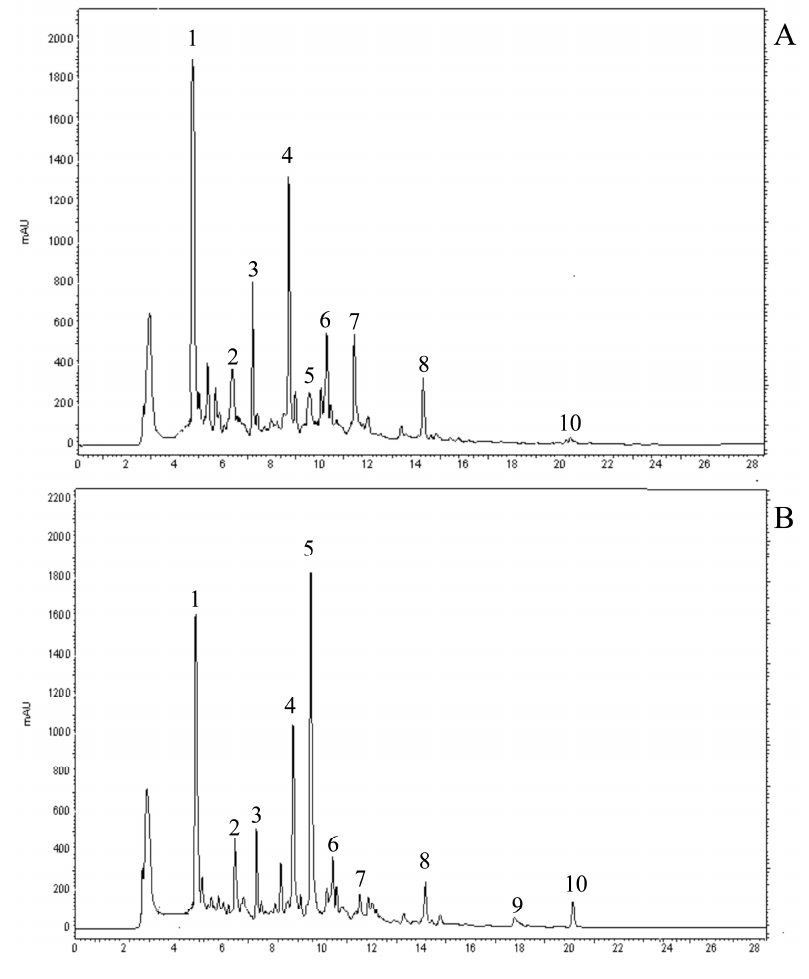
Figure 1. HPLC chromatograms of phenolic compounds in E92 before ( A ) and after ( B ) processing detected at 330 nm. Peaks: 1, chlorogenic acid; 2: caffeic acid; 3, 5- p -CQA; 4, rutin; 5, quercetin3- β - D-glucoside; 6, naringin; 7, kampferol-3-rutinoside; 8: chalconaringenin hexoside; 9, quercetin; 10: naringenin and chalconaringenin.